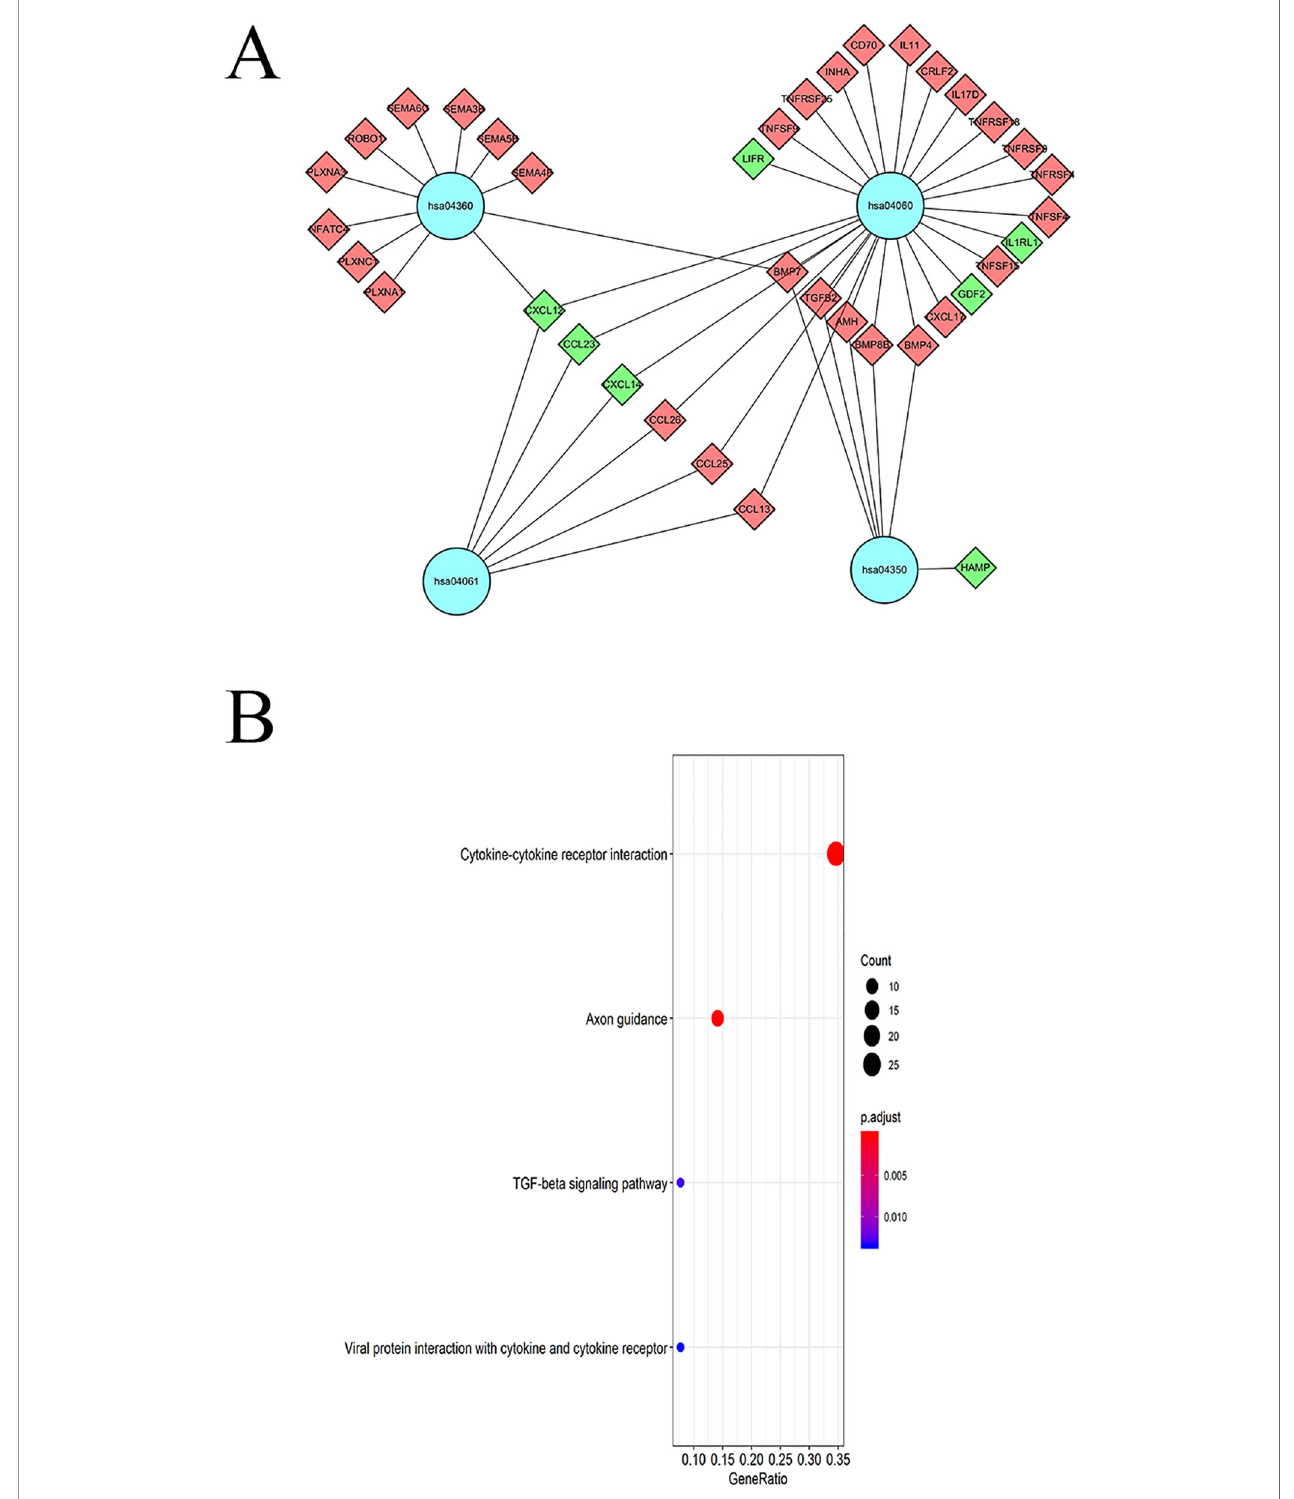
FIGURE 5 | KEGG pathway analysis of DEIGRs: (A) Relationship between IRGs and KEGG pathways. (B) The signi fi cantly enriched KEGG